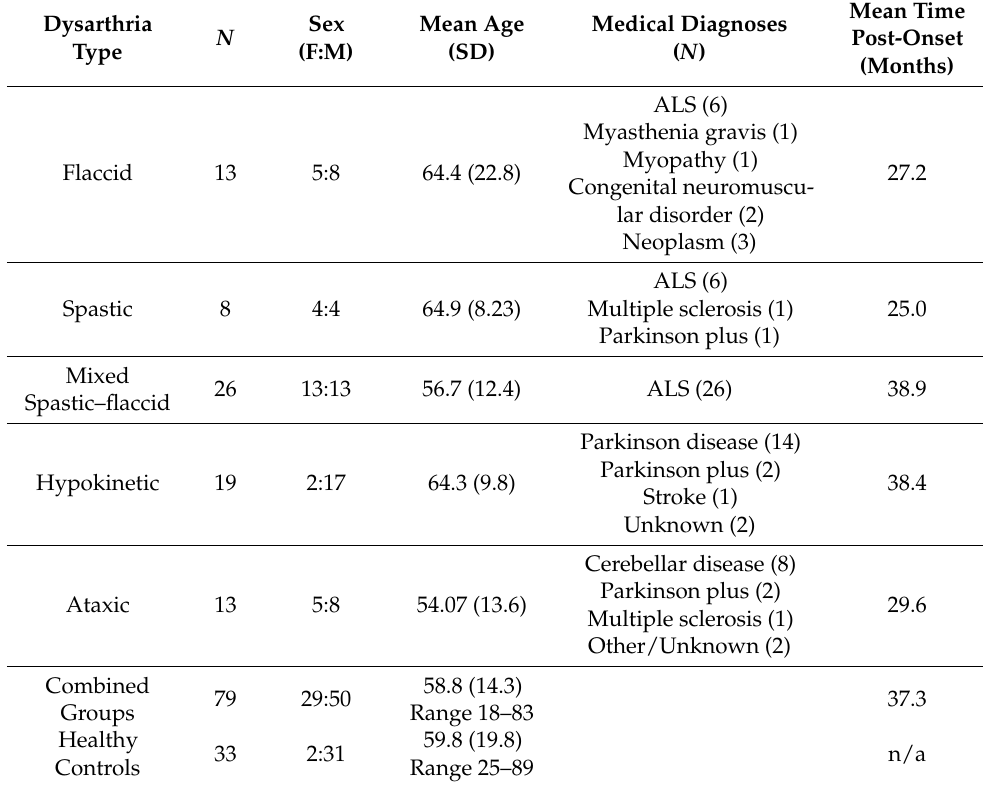
Table 1. Participant